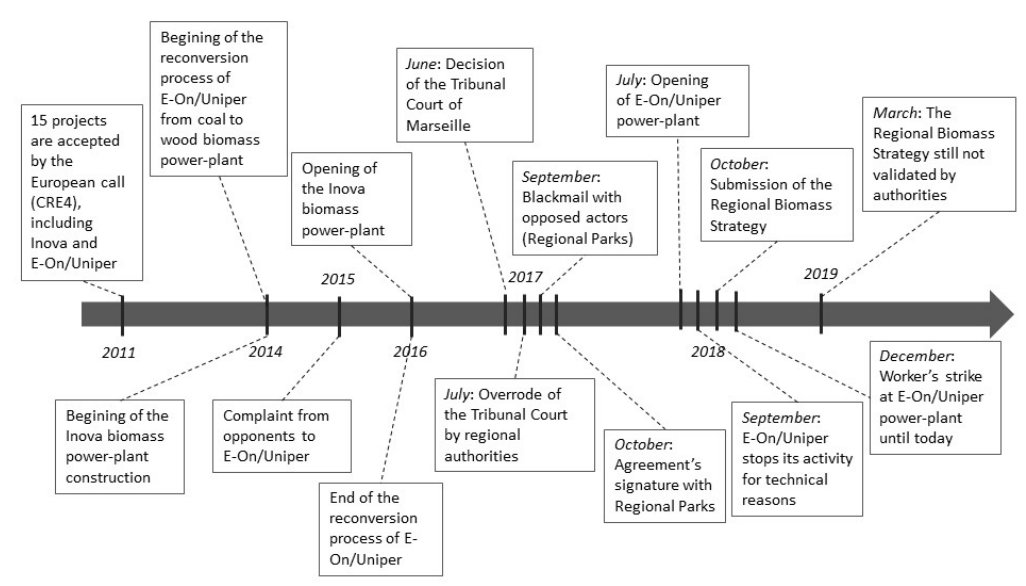
Figure 3. Chronology of the arrival of woody biomass mega power plants in the PACA region. Along with power-plants implementation by national authorities, several local actors have tried for many years to develop consistency in the forestry sector through the devel- opment of a collective heating network with community boilers at local scale (described ing number of regional small community wood-fired boilers, which increased from ap- proximatively 30 in 2003 to 284 in 2016 [34]. However, the lack of leadership in forest sector and the unstructured network limit the organization of actors as reflected by actor’s assertions during interviews (“Communication is very difficult, there are too many inter- locutors” (Forest operator, personal interview, May 2017); “The interprofessional struc- ture is too young to create cohesion between actors” (Foresters union member, personal interview, April 2017)). All the historical traits mentioned above result in low social capital and no common vision of the regional resource and long-term achievements. Conse- quently, Ostrom’s key conditions No 2 and 6 are not fulfilled (Box 1). 3.2. The Local Response to Top-Down Policy: Consequences of Lack of Information and Trust The E-On/Uniper and Inova power-plants offer economic and political opportunities for the region. However, at the same time, the top-down implementation of the national woody biomass policy has sparked considerable disruption in the regional governance and for local foresters and citizens (“It is a big project suddenly launched in a very fragile context” (Forest community association member, May 2017)). As explained in the previous section, regional forest actors have developed a collec- tive heating network of small boilers with short wood supply chains. Hence, the imple- mentation of the large E-On/Uniper power-plant in the region has been perceived as trea- son by foresters and regional decision-makers who work hard for the forest sector. Local actors perceive the wood energy approach as being probably more in line with the decen- tralised energy system imagined by Rifkin (2011) [52], an approach deeply rooted in the local territories breaking with the conventional centralised energy production based on huge energy power-plants. The giant E-On/Uniper company requires a much higher amount of wood resources, and has far greater harvesting capacities, than do local forest- ers. This situation drove several actors to prosecute E-On/Uniper in 2015 because of a